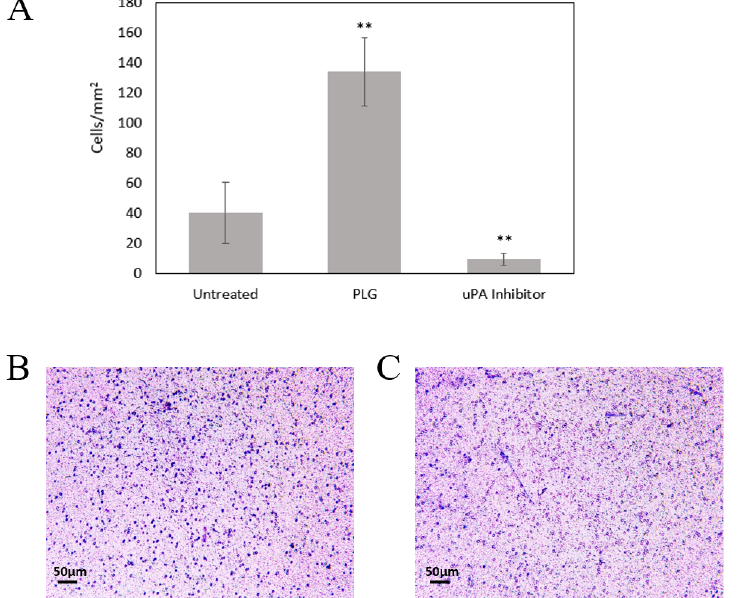
Figure 6. Plg Enhances MeT5A Invasion through a Collagen Matrix. ( A ) Lys-Plg increased Met5A invasion through a 2.65 mg/mL collagen matrix compared to untreated cells ( n = 3). Addition of uPA inhibitor significantly reduced migration ( n = 2), ** p < 0.001 by one-way ANOVA, mean ± SD. Representative images show cell movement through a collagen-coated Transwell membrane in the presence ( B ) or absence ( C ) of Plg. Cells attached to the lower membrane were fixed and visualized with crystal violet 24 h after seeding in the upper insert.